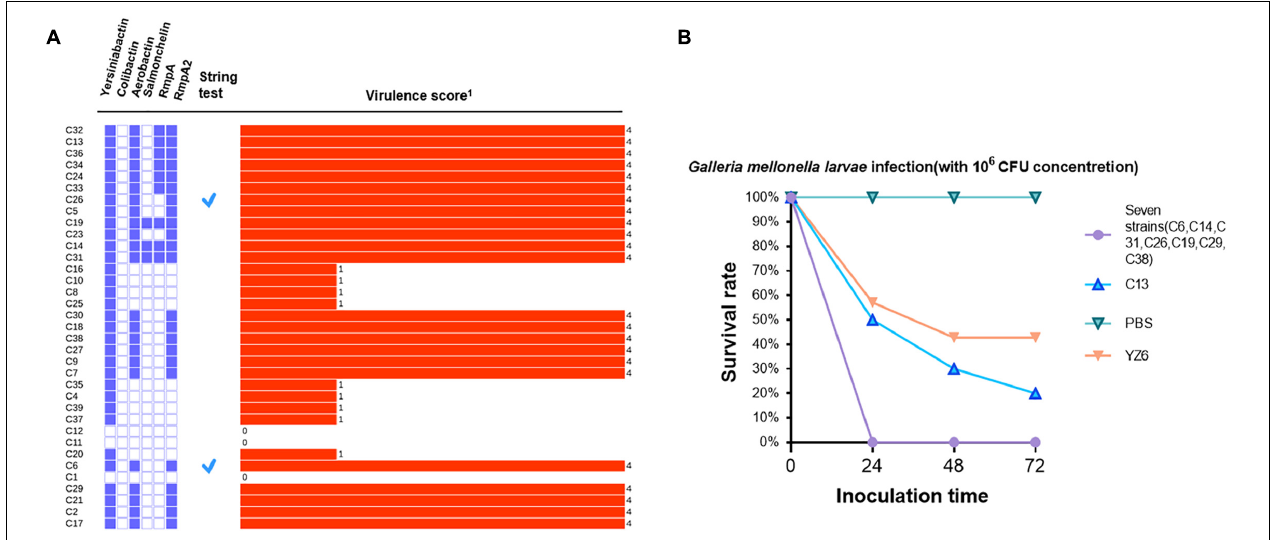
FIGURE 3 | (A) Virulence gene distribution, string test, and virulence scores of all CRKP isolates. The distribution of virulence factors is shown in purple solid (positive) and hollow (negative) rectangles. A tick represents positive result of string test, and the virulence score is shown by a red bar and marked with corresponding numbers in right. (B) . Virulence potential of eight CRKP strains in a G. mellonella larvae infection model. The effect of 1 × 10 6 CFU of each strain on survival was assessed in G. mellonella larvae. 1 Virulence score is determined by Kleborate software; virulence increases with the